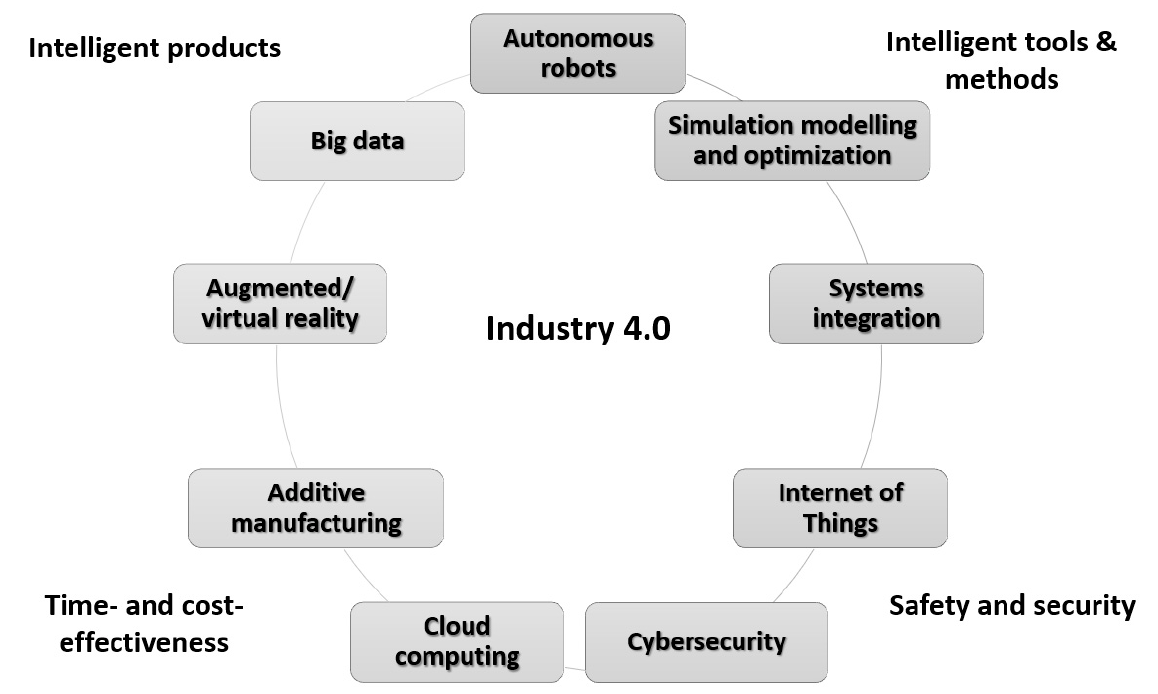
Figure 3. Technologies prevalent in Industry 4.0. Source: own contribution based on [53].